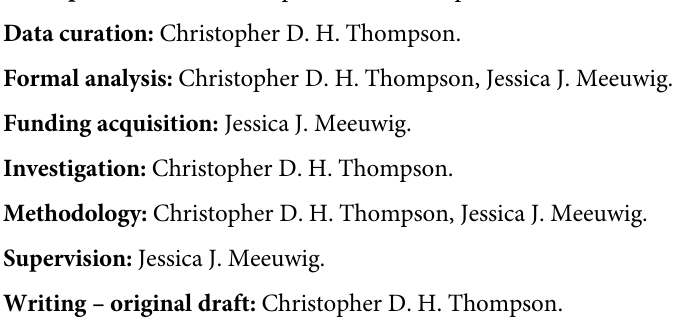
S1 Fig. Schematic of a) defined body areas scraped on the scraper’s body and b) defined areas for contact by scrapers on the scrapee’s body. S1 Table. Locations sampled with mid-water BRUVS by the Marine Futures Lab from 2012–2019. Number of mid-water BRUVS deployments at each sample locations and number of deployments on which scraping behaviour was observed on preliminary